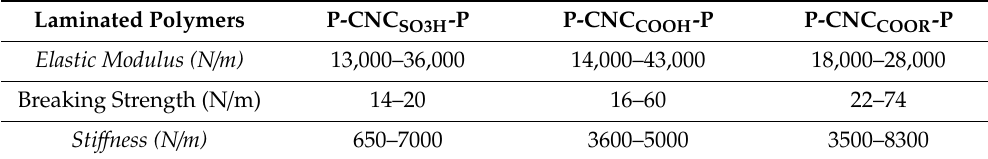
Table 3. Results of peeling test of laminated coated-polymers. Laminated Polymers